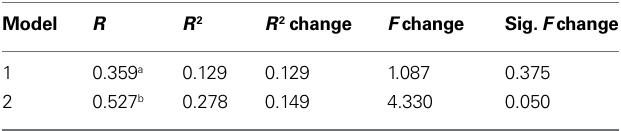
Table 3 | Multiple regression analysis for left posterior limb of internal capsule + alerting.